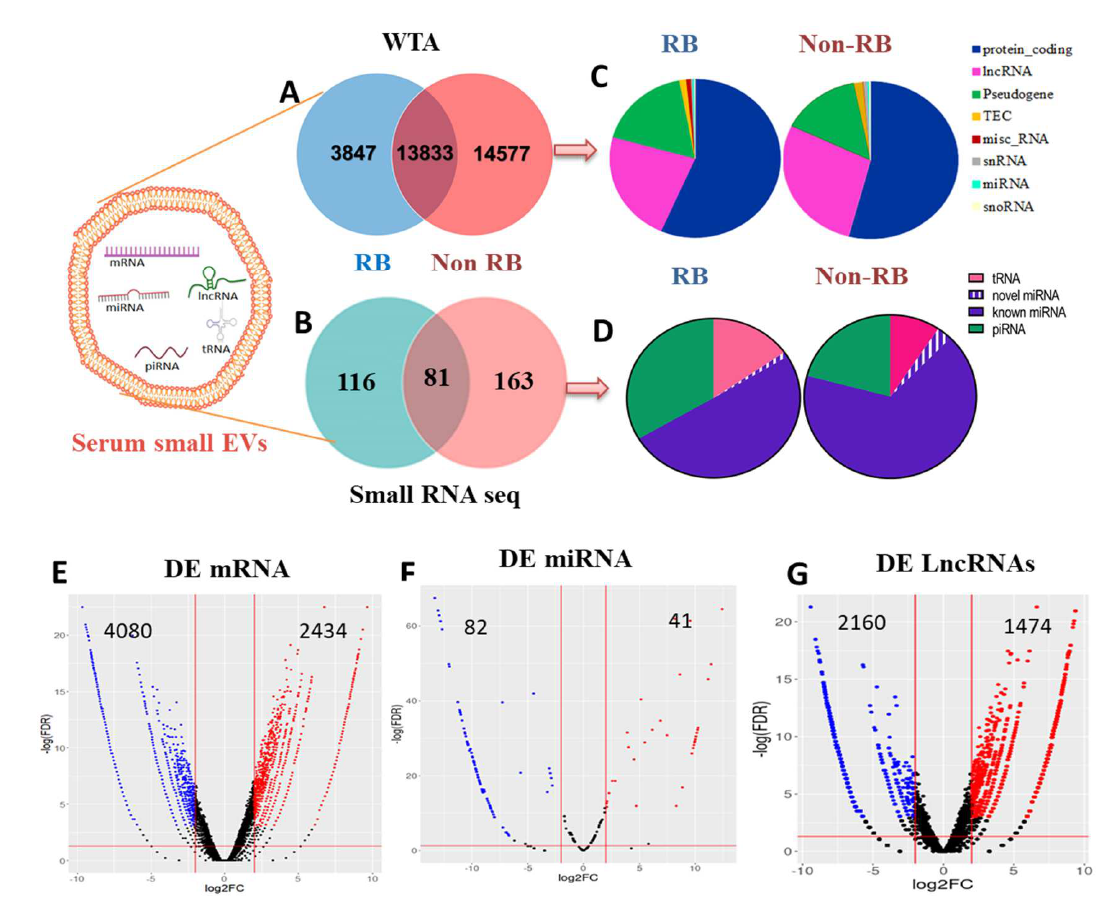
Figure 2. Total RNA profiles and distribution of RNA biotypes present in serum-derived small extracellular vesicles (sEVs) of retinoblastoma (RB) and age-matched controls (non-RB). ( A , B ) The Venn diagram depicts the fractions of unique and shared transcripts by RB and non-RB sEVs. ( C , D ) Pie charts show RNA categories of sEVs identified by WTA and small RNA sequencing. Volcano plot of differentially expressed (DE) ( E ) mRNAs, ( F ) microRNAs, and ( G ) long non-coding RNAs of retinoblastoma (RB) vs. non -RB serum-derived small EVs identified by EdgeR. Blue dots >= Down regulated genes; Red dots: upregulated genes; Black >= neural based on p < 0.05 and log2foldchange of (+/−) 2 criteria.